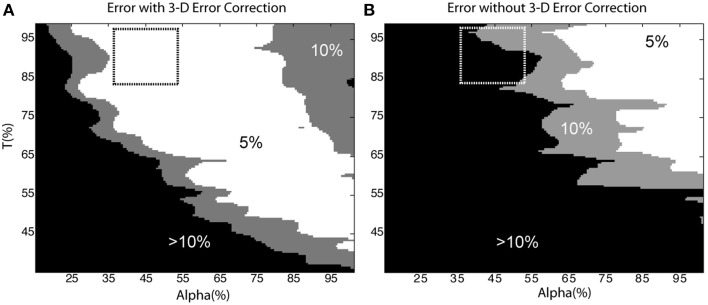
Sensitivity to user-defined parameters. Cell count error as a function of α and T with (A) and without (B) 3-D error correction. The dashed box indicates the parameters an operator would likely select based on histogram data from the software. In (A) the 5% error region occupies 44% of the shown parameter space; in contrast, the same error region occupies only 18% of (B). The removal of neurite segments and the merging of over-segmented somata in (A) accounts for the reduced sensitivity to user defined parameters.